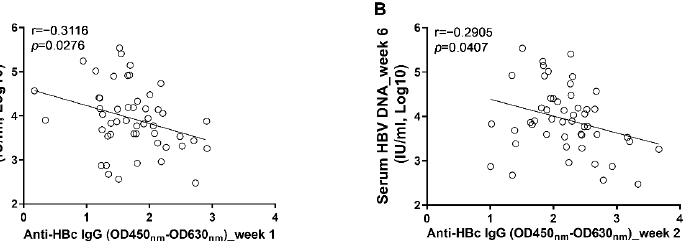
Figure 6. The levels of anti-HBc IgG response at the early phase of infection were associated with the levels of circulating HBV DNA at the phase of stable infection. ( A ) the correlation between levels of anti-HBc IgG at 1 wpi and concentrations of serum HBV DNA at 6 wpi; ( B ) the correlation between levels of anti-HBc IgG at 2 wpi and concentrations of serum HBV DNA at 6 wpi. Statistical analysis was performed by the method of Pearson correlation ( n = 50).